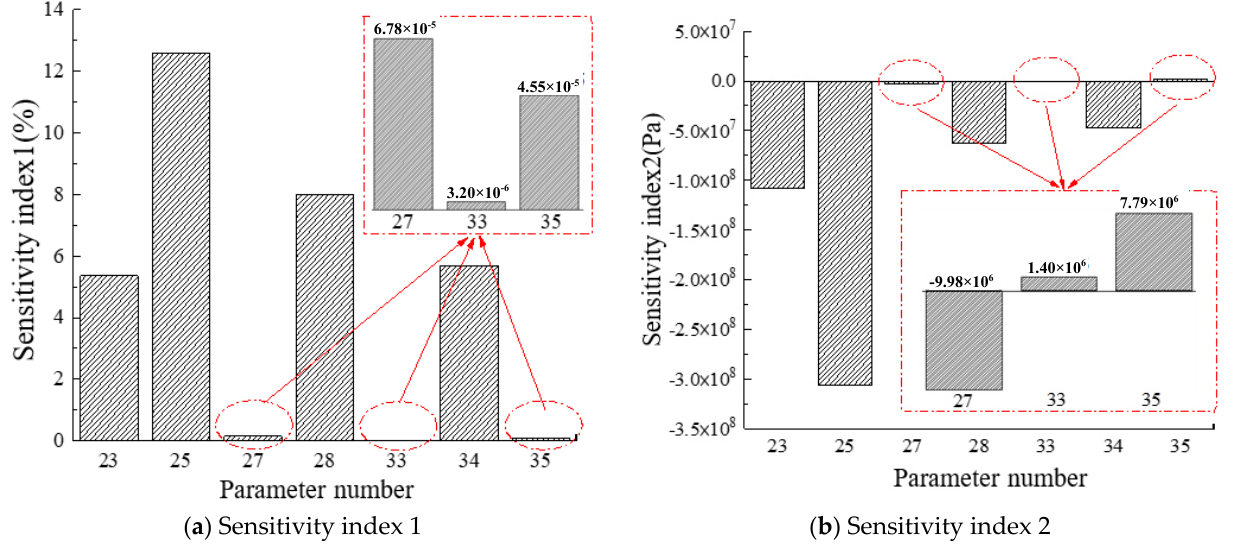
Figure 15. The sensitivity index resulting from actuator parameter variation.